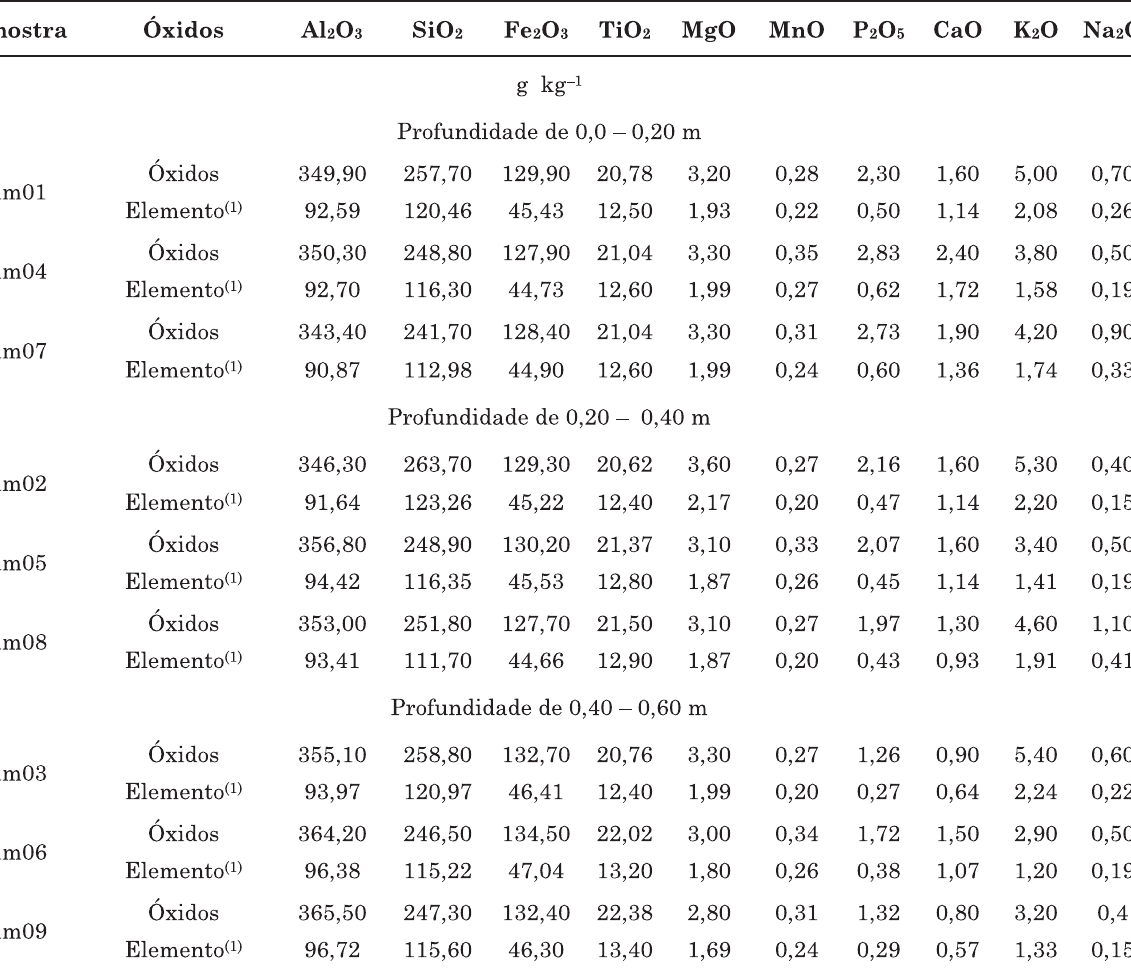
respectivamente.Quadro 1. Teores dos óxidos e respectivos elementos (referentes ao cátion constituinte do óxido)